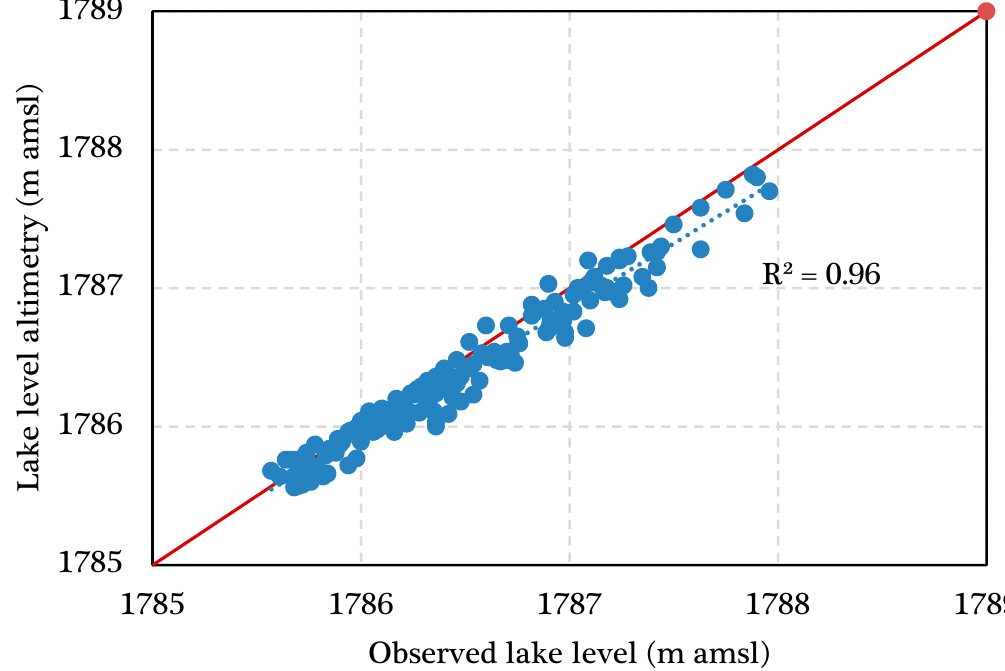
Figure 13. Comparison of observed lake level and Jason-1 lake level altimetry for Lake Tana (1993– 1996).